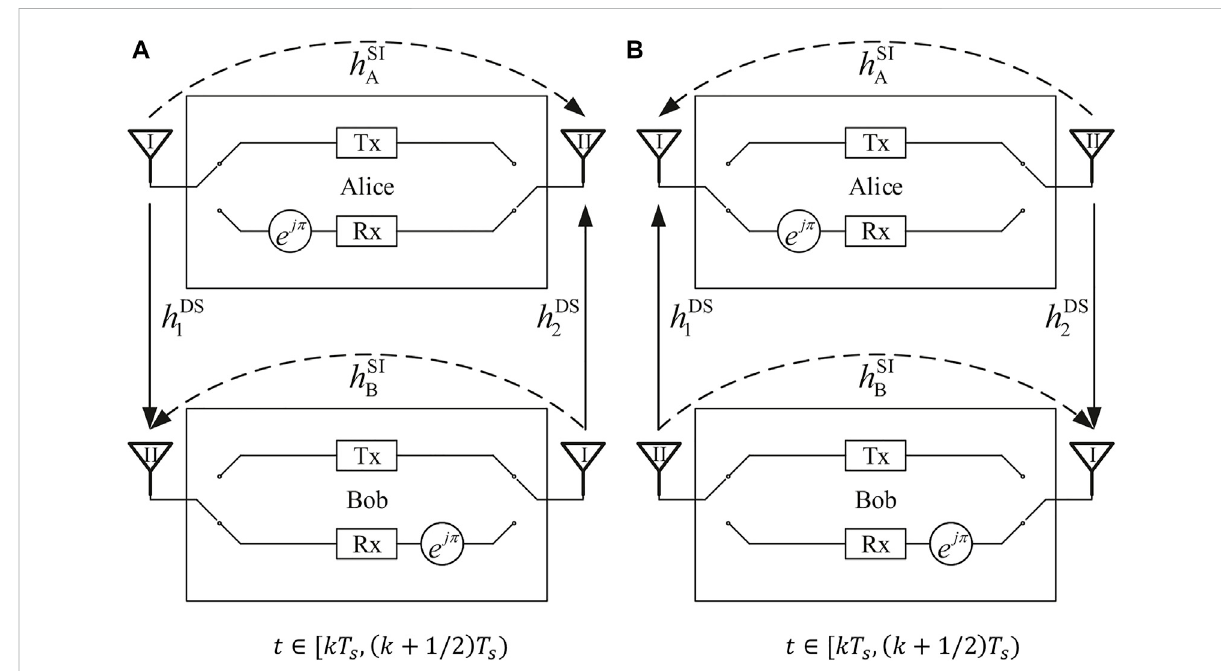
FIGURE 2 The system structure of pseudo-Doppler aided SI cancellation: (A) t ∈ [ kT s ( k + 1/2) T s ), (B) t ∈ [( k + 1/2) T s ( k + 1) T s ), k ∈ Z